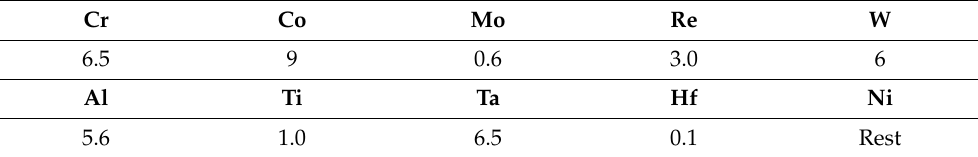
Table 1. Chemical compositions of CMSX-4 (wt%).